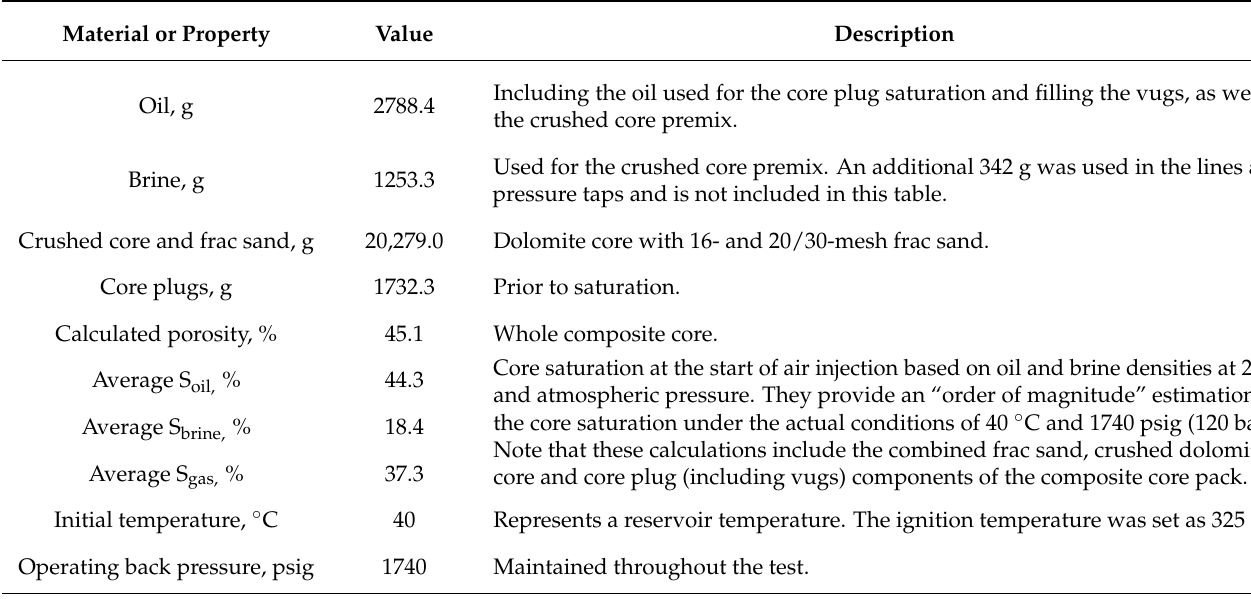
Table 3. Packing details and reservoir properties.